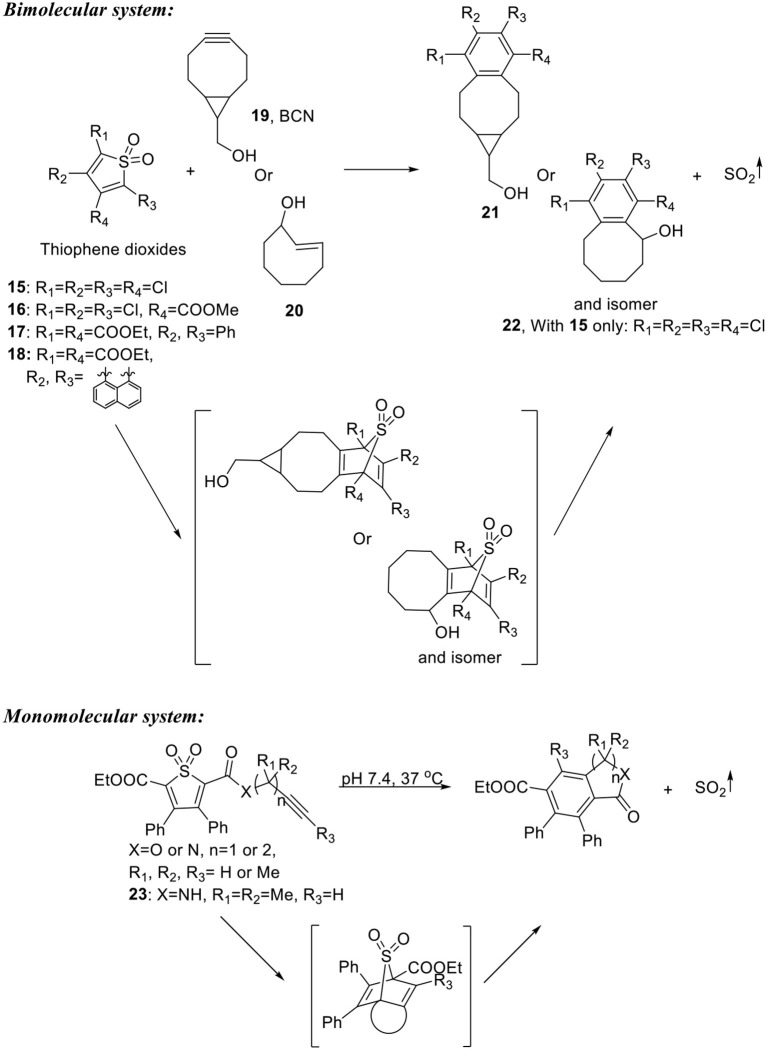
Click-reaction-based SO2 prodrugs.